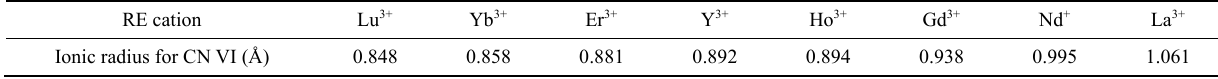
Table 1 List of trivalent RE cations and their respective ionic radii for coordination number (CN) VI [26]